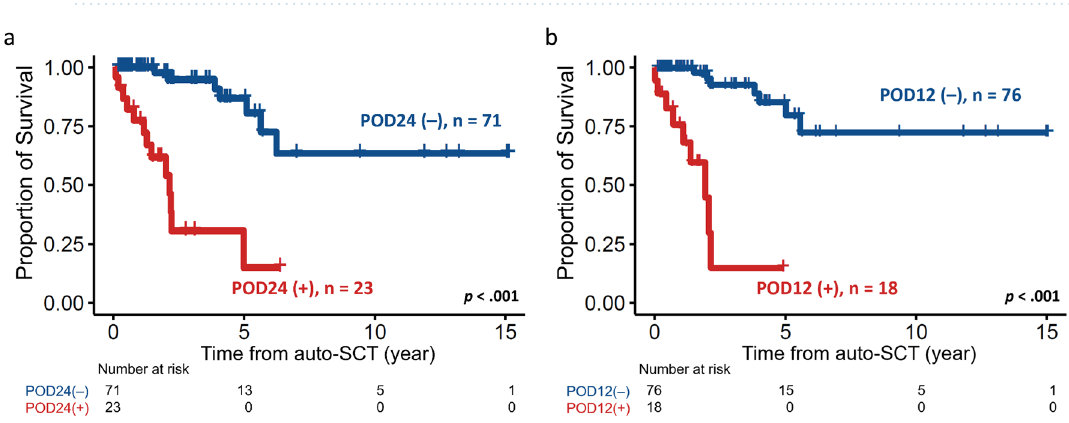
Figure 4. Kaplan–Meier plots stratified by progression of disease post-auto-SCT or not. ( a ) Patients who had progression of disease within 24 months (POD24) post-auto-SCT had a significantly shorter survival. ( b ) POD12 also predicted an inferior post-auto-SCT